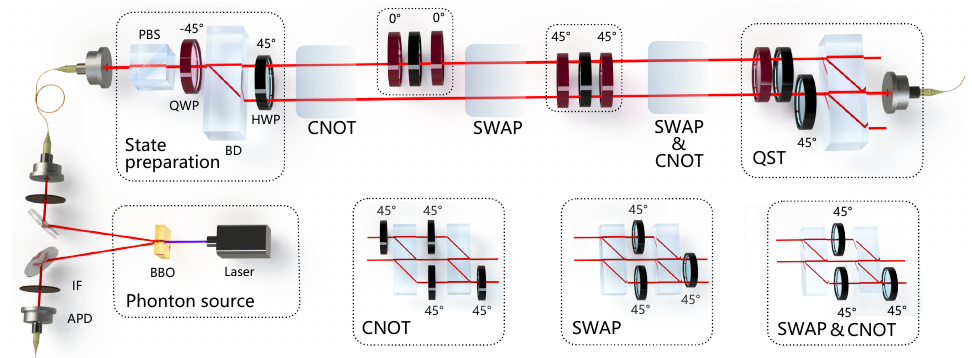
Figure 1. Photon pairs are produced via type-I spontaneous parametric down-conversion process by pumping a 1 mm-thick BBO nonlinear crystal with a 405 nm laser diode. Two IFs filter out the pump and restrict the photon bandwidth to 3 nm. The operations (CNOT and SWAP) are realized with combinations of BDs and HWPs at 45 ◦ . The system qubit is polarization analyzed via a QST module consisting of a QWP and two HWPs followed by a BD in front of an APD. Coincidence measurements are performed via APDs. BD, beam displacer; HWP, half-wave plates; QWP, quarter-wave plate; PBS, polarizing beam splitter; IF, interference filter; BBO, β -barium-borate; APD, avalanche photodiodes. The heralded photons are polarized by passing through a polarizing beam splitter (PBS). Then, a quarter-wave plate (QWP) with setting angles θ P is inserted to rotate the Q polarizations of the